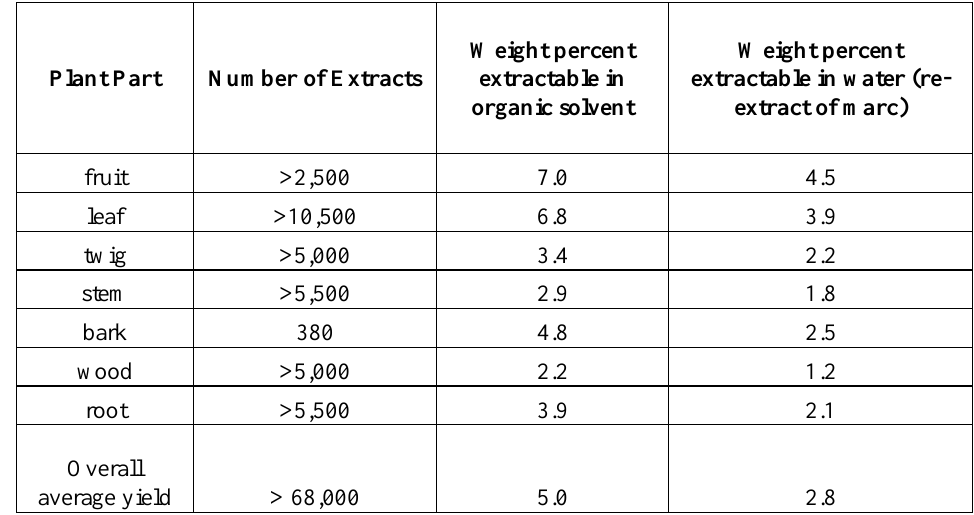
Table 4. Average percent weight extracted by organic solvent (DCM/MeOH), followed by water. (Relatively low numbers are the result of most specimens containing multiple plant